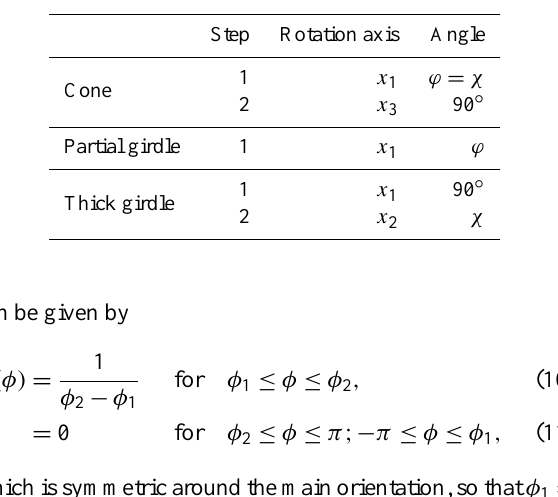
Table 2. Steps for calculation of elasticity tensor (Eq. 13) or com- pliance tensor (Eq. 13) for different fabrics (Table